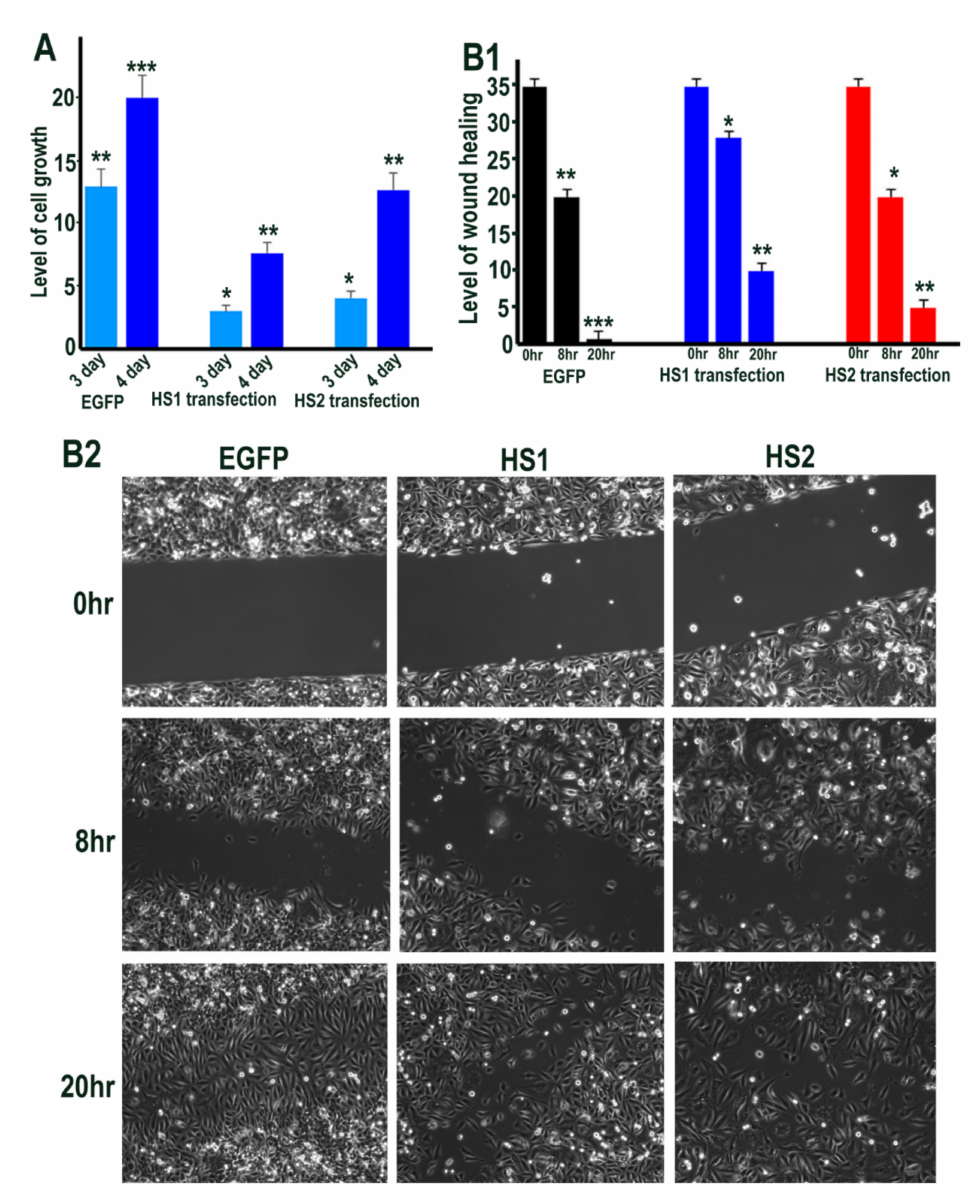
Figure 9. ( A ) Represents the changes in cell proliferation or relative cell mass of EGFP (control), HS1 (Sulf1) and HS2 (Sulf2) transfected ea926 cells following absorbance measurements of SRB stain at OD 565 nm after 3 or 4 days of growth by comparing growth at day 1. ( B1 , B2 ) represent the changes in wound healing/cell migration in control (EGFP) versus Sulf1 (HS1) and Sulf2 (HS2) transfected cells at 8 and 20 h following insert removal. Error bars = means ± SD; *** p < 0.0001; ** p < 0.001; * p < 0.01. The effect of Sulf1 and Sulf2 overexpression on ea926 cell migration was also examined using a wound-healing assay. This protocol demonstrated reduced migration rates in both Sulf1 and Sulf2 transfected cells, although the reduction in Sulf1 was greater than in Sulf2 transfected ea926 cells (Figure